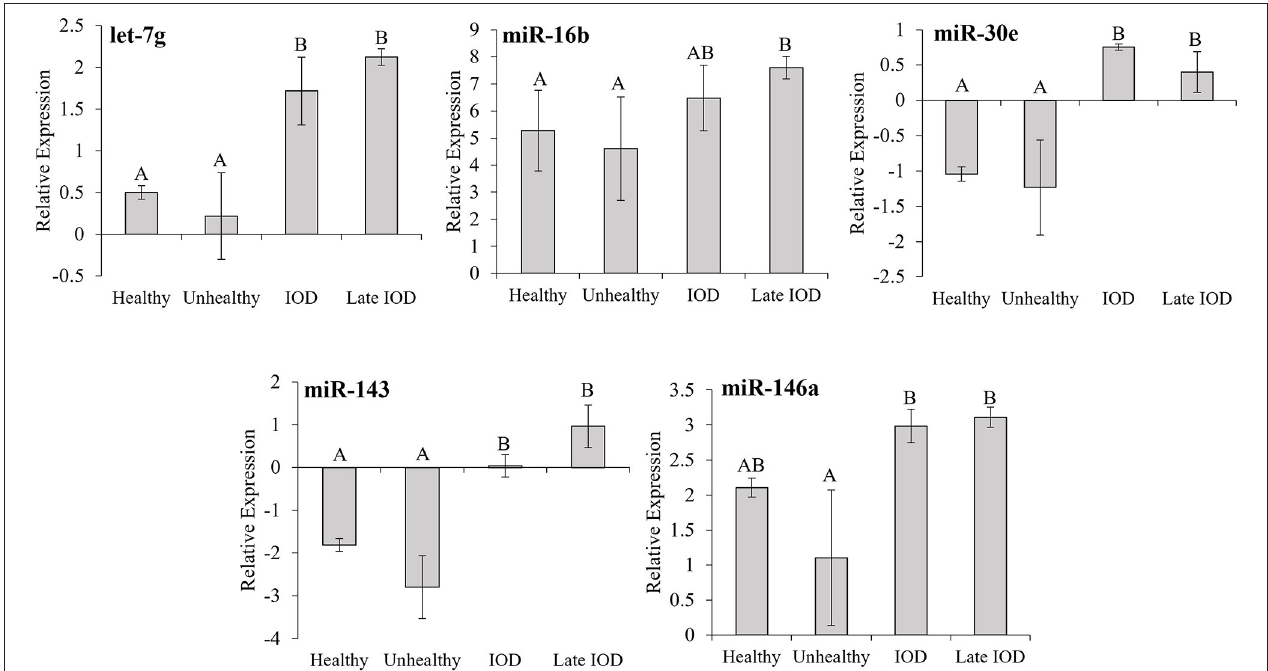
FIGURE 2 | Average normalized relative expression of miRNAs let-7g, miR-16b, miR-30e, miR-143, and miR-146a in healthy ( n = 80), unhealthy ( n = 7), and IOD afflicted ( n = 12) black ( Diceros bicornis ) and Sumatran ( Dicerorhinus sumatrensis ) rhinos as determined by RT-qPCR. Relative expression was determined following normalization using a global mean with consideration of house-keeping miRNAs. IOD afflicted samples were separated into two groups: IOD ( > 1 year but < 2 years prior to death; n = 5) and late IOD ( ≤ 1 year prior to death; n = 7). Data represent mean ± SEM. Different letters indicate statistical differences among states within each miRNA expression group ( P ≤